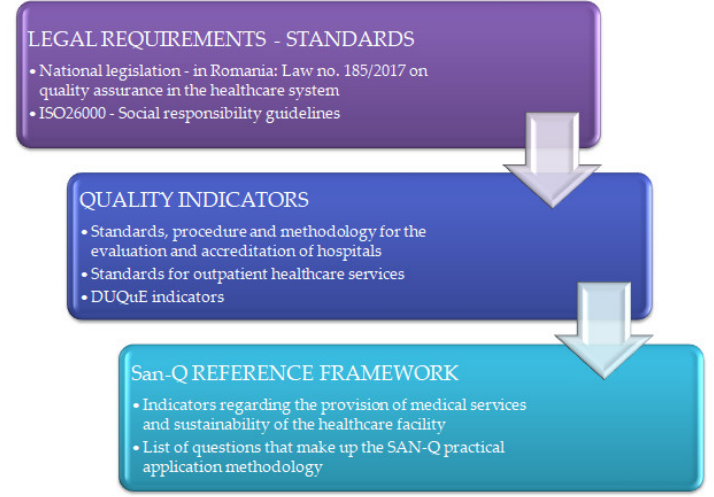
Figure 1. Conceptual model for the San-Q reference framework development.